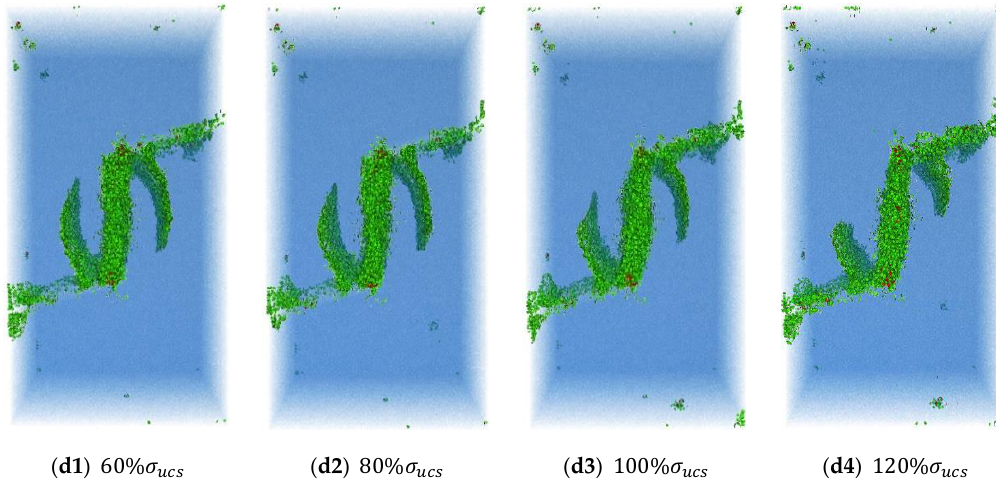
Figure 14. 3-D final failure patterns of various marble specimens, i.e., ( a1–a4 ) Type A, ( b1–b4 ) Type B, ( c1–c4 ) Type C and ( d1–c4 ) Type D, under unloading conditions with different initial confining pressures.